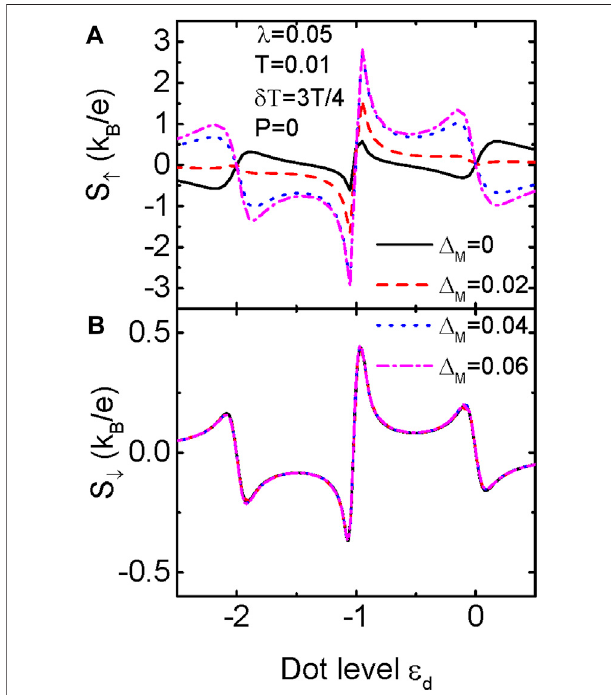
FIGURE 4 | Thermopower for spin-up electrons in (A) and spin-down ones in (B) as functions of the dot level for varying MZM-MZM coupling strength Δ M for indicated